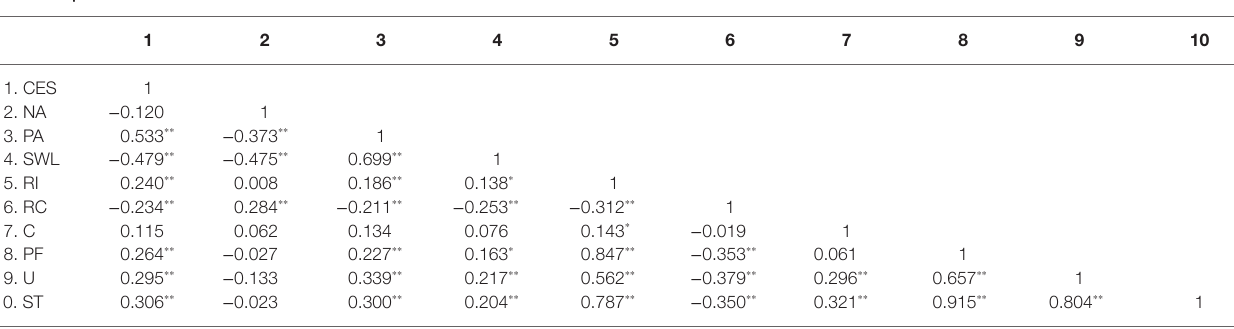
TABLE 1 | Correlations between variables of